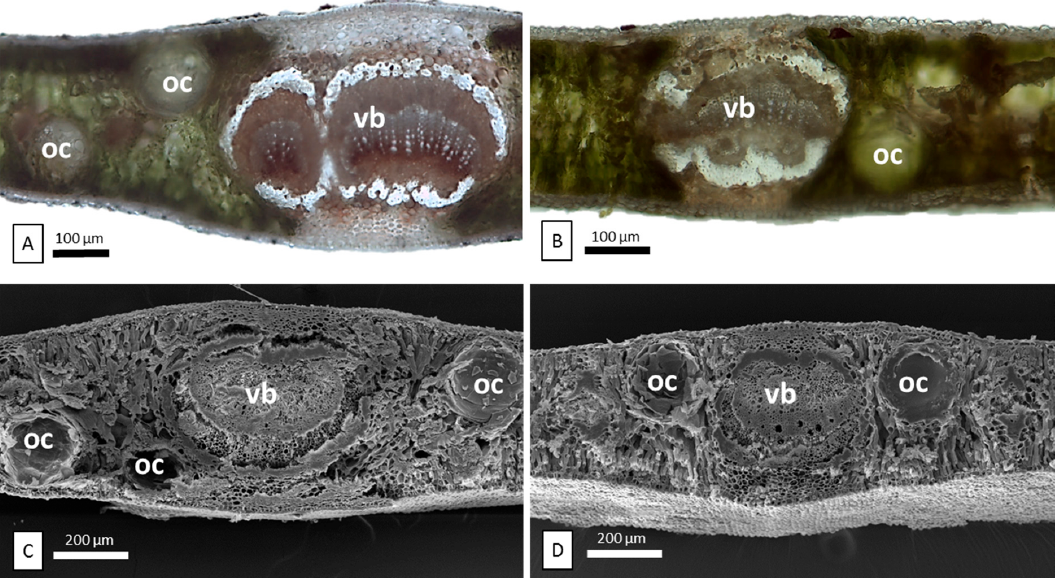
Figure 2. Light microscopy and SEM images.Transverse sections through leaf midrib of E. cinerea ( A , C ) and E. nicholii ( B , D ) showing vascular bundles (vb) and oil cavities (OC) within the mesophyll.